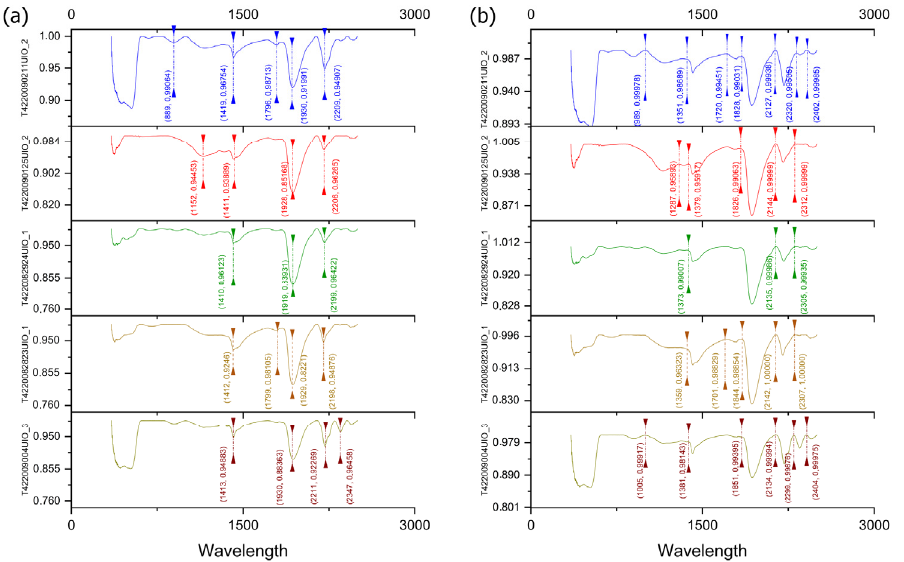
Figure 11. Absorption and reflectance peaks from spectra collected from samples of Tysfjord K-feldspar. ( a ) Main absorption peaks (minimum). ( b ) Main reflectance peaks.